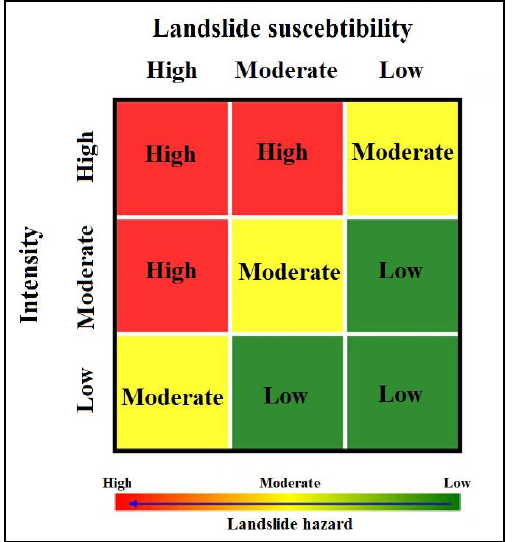
Figure 5. The high-moderate-low landslide hazard assessment using a landslide hazard matrix (after Hürlimann et al.,